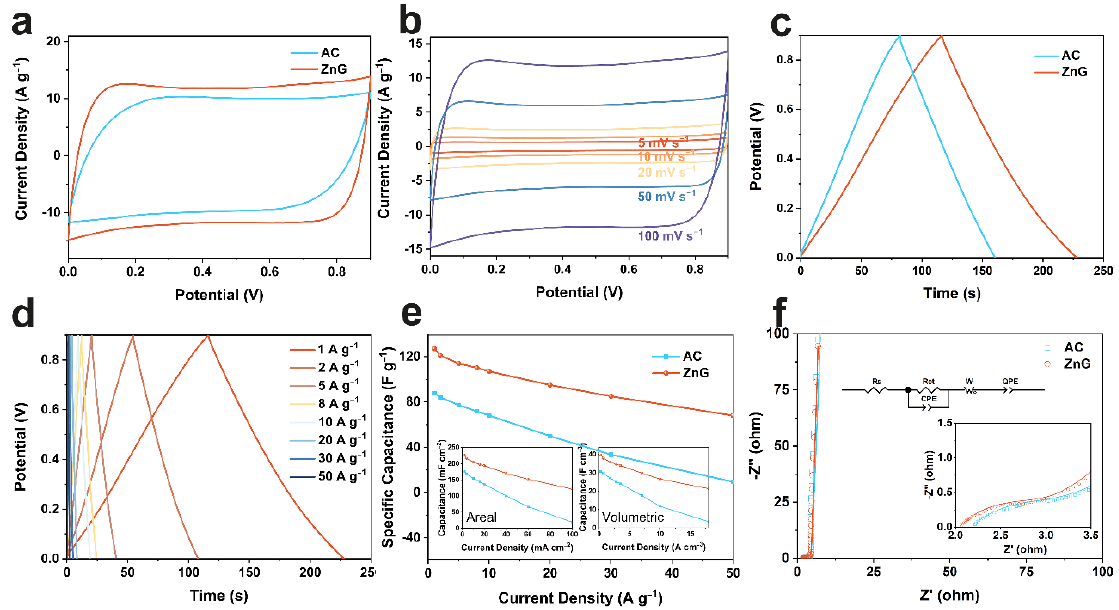
Figure 3. Electrochemical performance of ZnG and AC in three-electrode system. CV curves at 100 mV · s − 1 ( a ); CV curves of ZnG at different scan rates ( b ); GCD profiles at 1 A · g − 1 ( c ); GCD profiles of ZnG at different current densities ( d ); specific capacitance at different current densities, which insets are areal and volumetric capacitance ( e ); and Nyquist plots with the equivalent circuit ( f